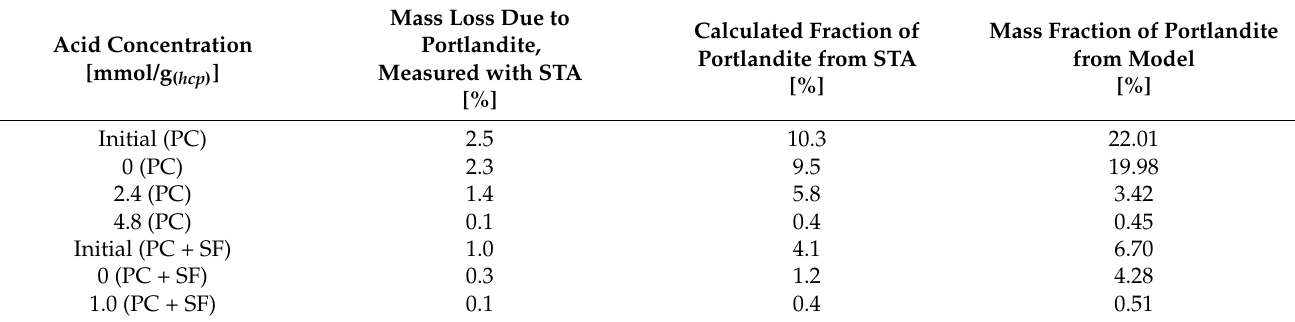
Table 4. Comparison of Portlandite fractions determined by modeling and by STA